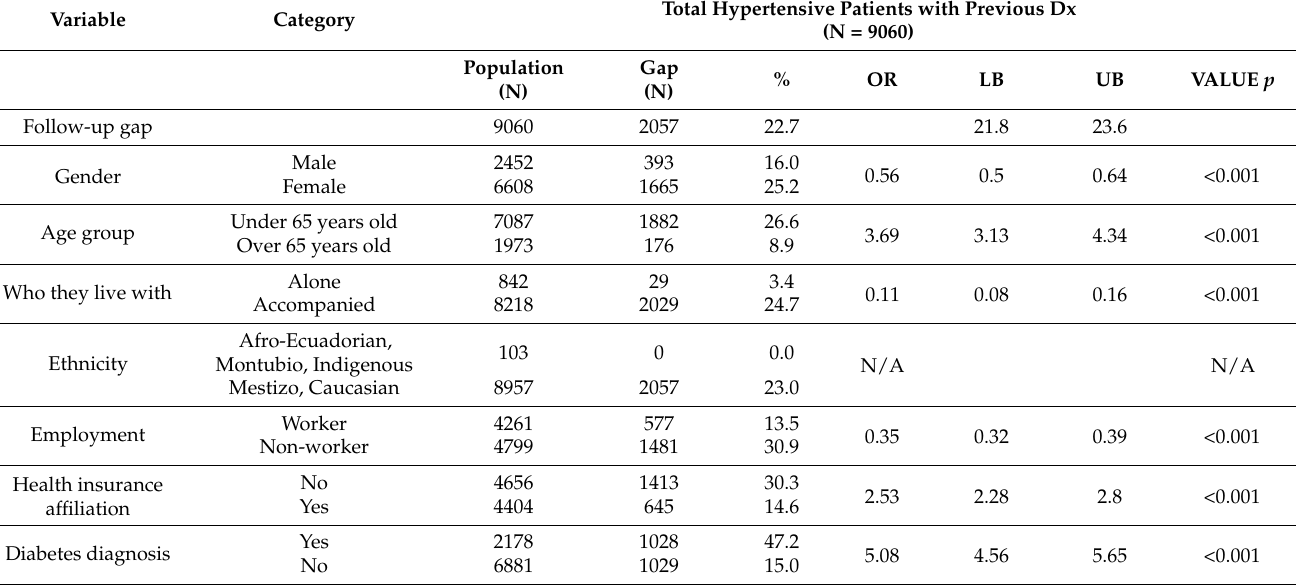
Table 3. Follow-up gap, associated